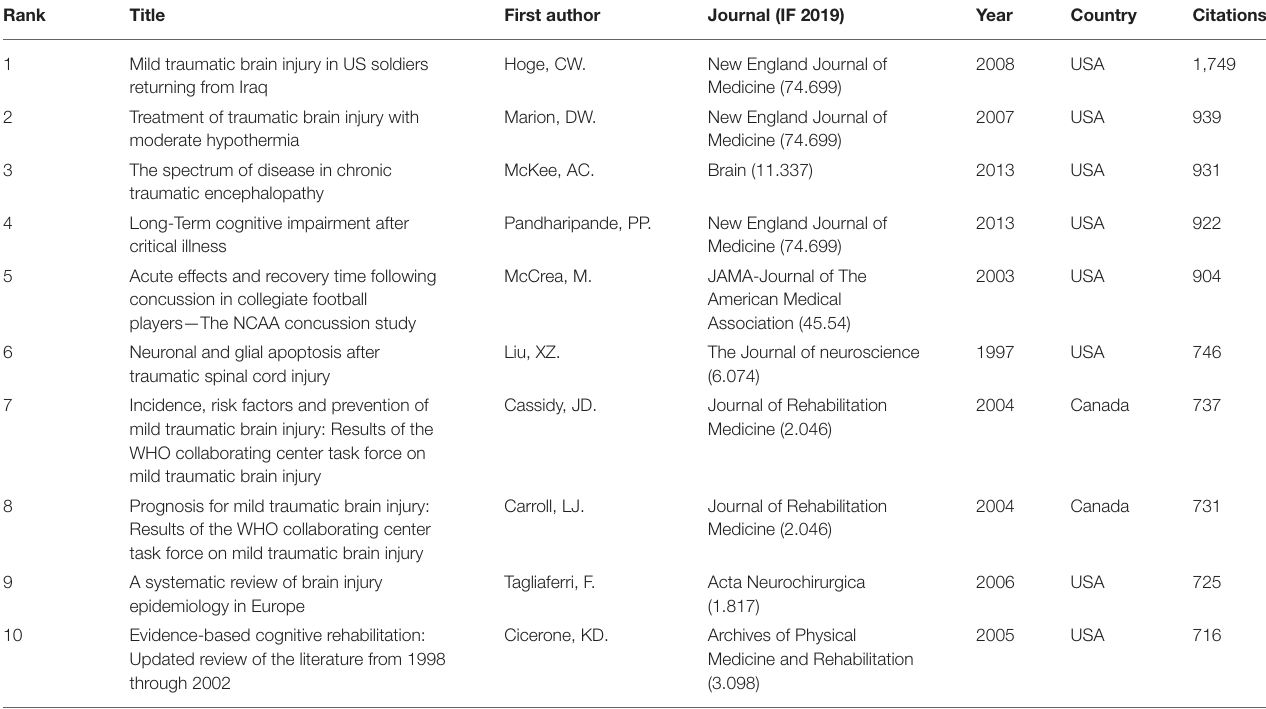
TABLE 2 | The Top 10 most-cited articles on mTBI.